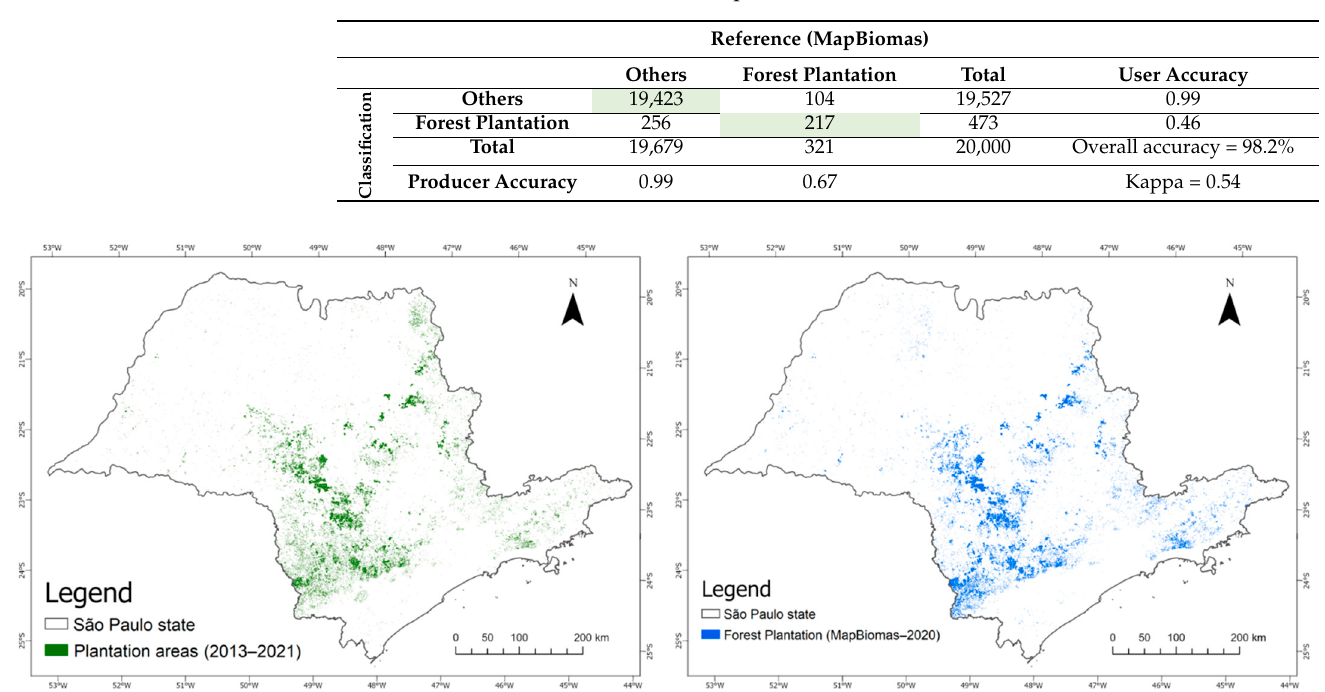
Table 3. Confusion matrix for the forest plantation classification in 1995.